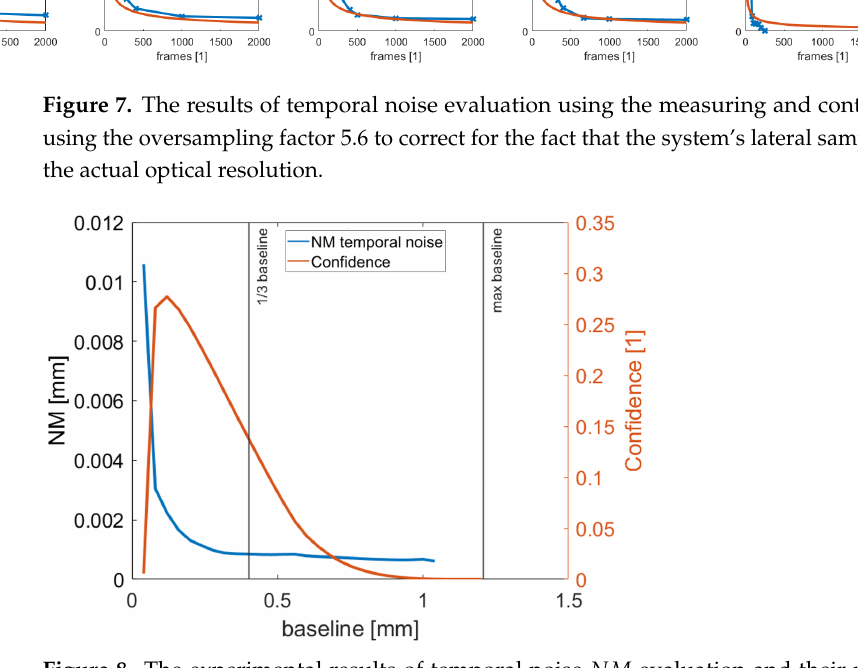
Figure 8. The experimental results of temporal noise NM evaluation and their mean confidence using the measuring and control surface plate using different